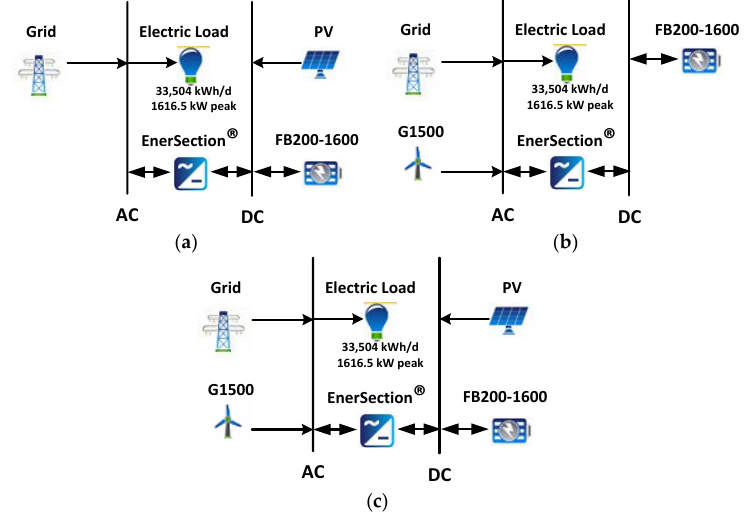
Figure 1. Schematic diagram of the power systems simulated in HOMER software: ( a ) solar; ( b ) wind; and ( c ) hybrid (wind/solar) power systems.